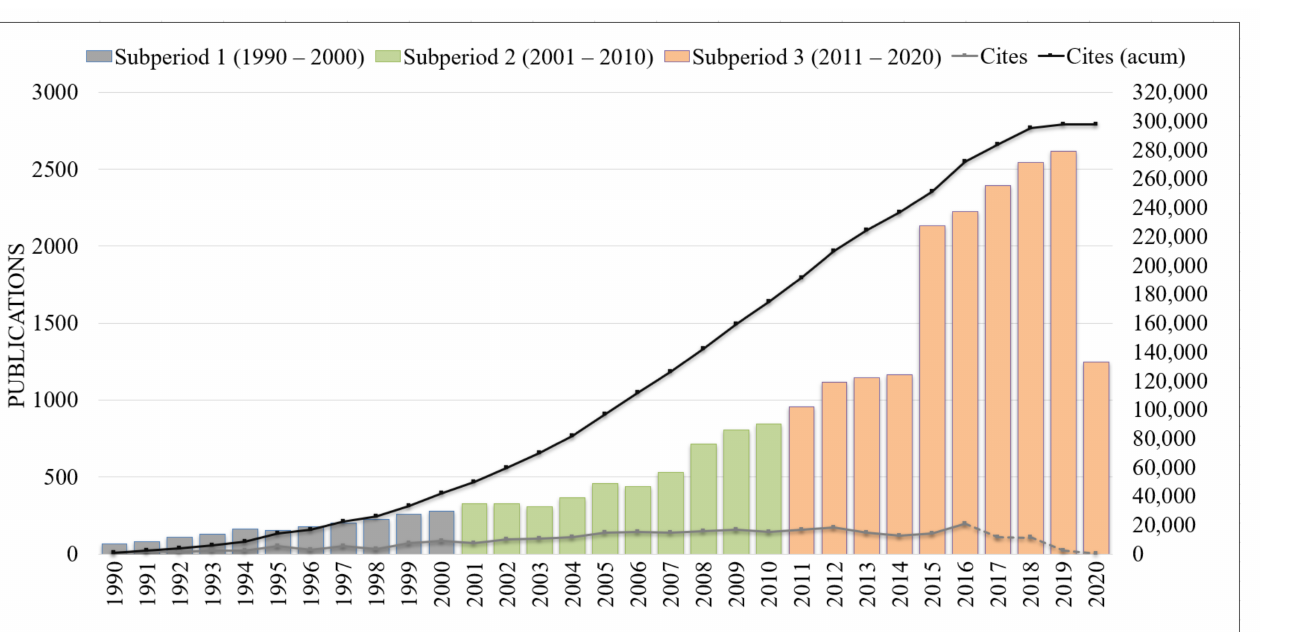
Figure 2. Number of publications on the topic of human rights over time (1990–June